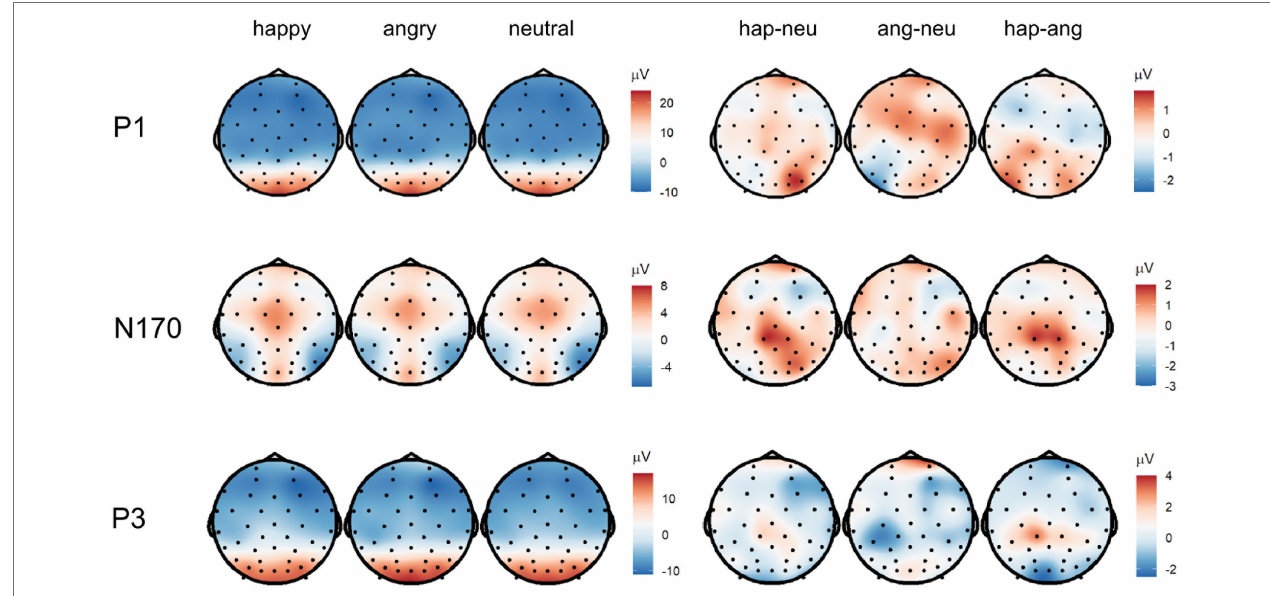
FIGURE 5 | Topographies of the averaged P1 (90–130 ms), N170 (180–220 ms), and P3 (300–500 ms) activity displaying scalp topographies and difference topographies (in μ V) for the emotion